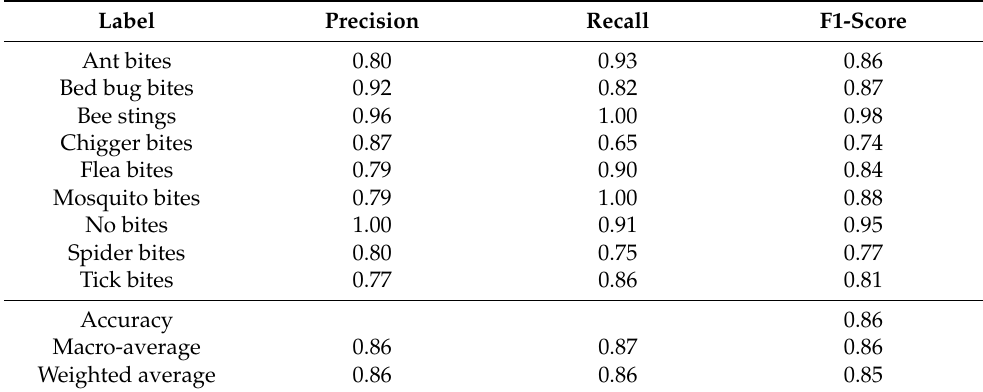
Table 14. Evaluation metrics for Neural Network Stacking Ensemble model.